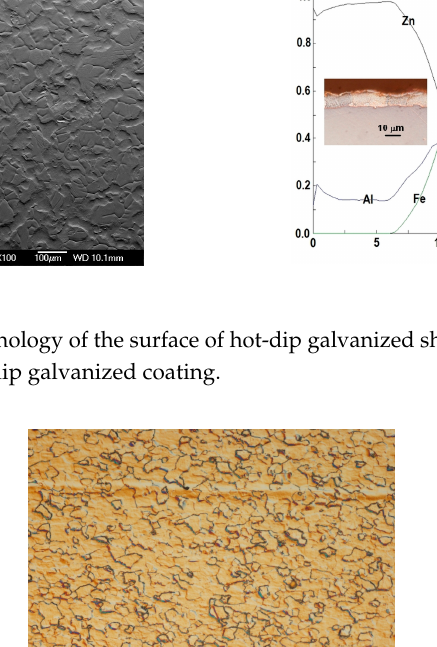
Figure 6. Microstructure of H220PD + Z100MBO.